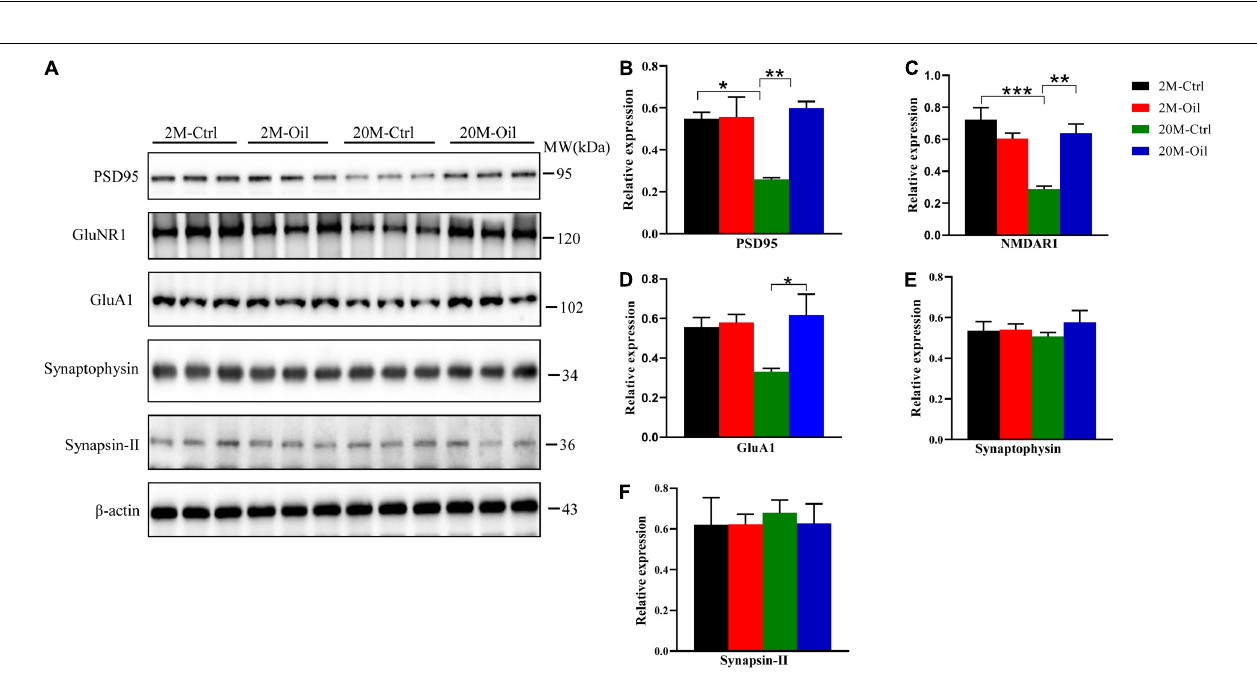
FIGURE 5 | Acer truncatum seed oil increased expression of synapse-related proteins in aging mice. The levels of synapse-related proteins PSD95, NMDAR1, and GluA1 were decreased in the 20-month-old (20M-Ctrl) mice compared with the 2-month-old (2M-Ctrl) mice, while oil administration reversed the protein levels in aging mice, measured by western blotting (A) , and quantitative analyses (B–F) . One-way ANOVA followed by Tukey’s multiple comparison tests, * p < 0.05, ** p < 0.01, *** p < 0.001. All data were expressed as mean ± SEM. n = 3 mice for each group.